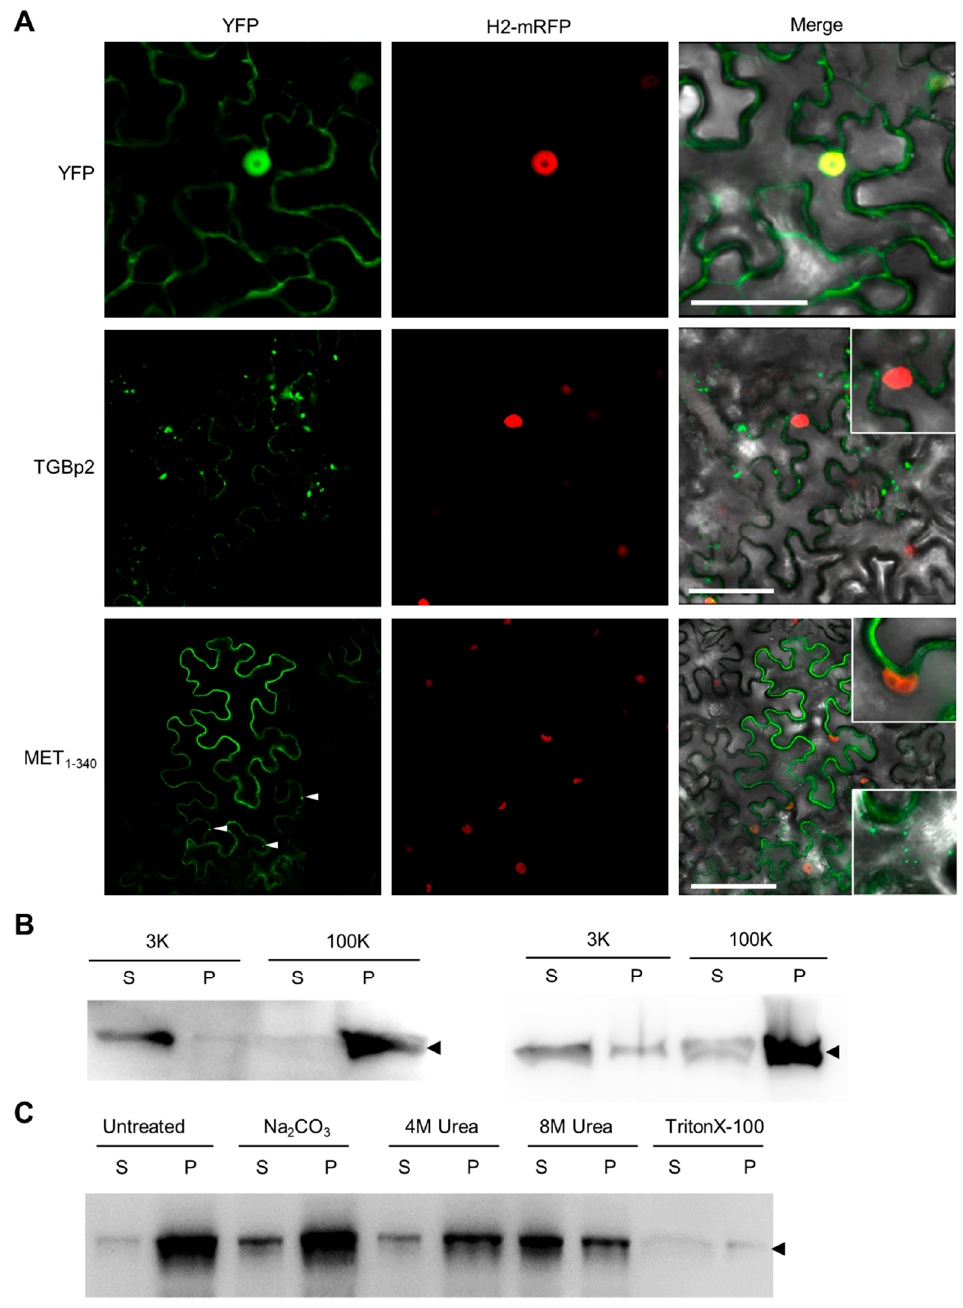
Figure 1. MET 1-340 associated with ER. ( A ) Confocal microscopic photos of N. benthamiana epidermal cells expressing YFP, TGBp2-YFP, or MET 1-340 -YFP at 2 dpi. The nucleus is labeled by H2-mRFP. Insets show the typical nuclear signal. Scale bars = 50 μ m. ( B ) Western blotting analysis pellets (P) and supernatants (S) of 3000 g (3K) and 100,000 g (100K) centrifugation by anti-GFP (left panel) or anti-mRFP antibodies (right panel). ( C ) Western blotting analysis showing the presence of MET 1-340 -YFP after the treatment of Na 2 CO 3 , urea, or TritonX-100 and 100,000 g centrifugation by anti-GFP antibodies.